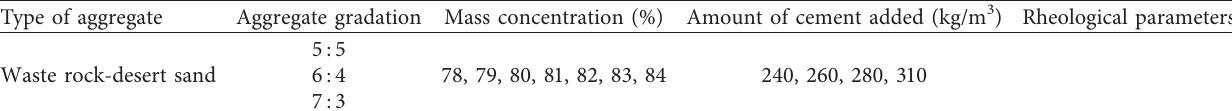
Figure 7: Loading and thixotropic control of the RheoCAD500 rheometer. Table 2: Rheological test of paste filling